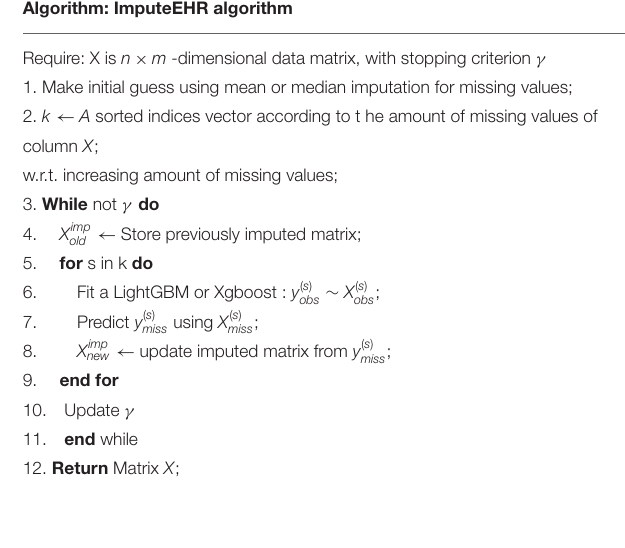
TABLE 2 | Pseudocode of the ImputeEHR algorithm. Algorithm: ImputeEHR algorithm